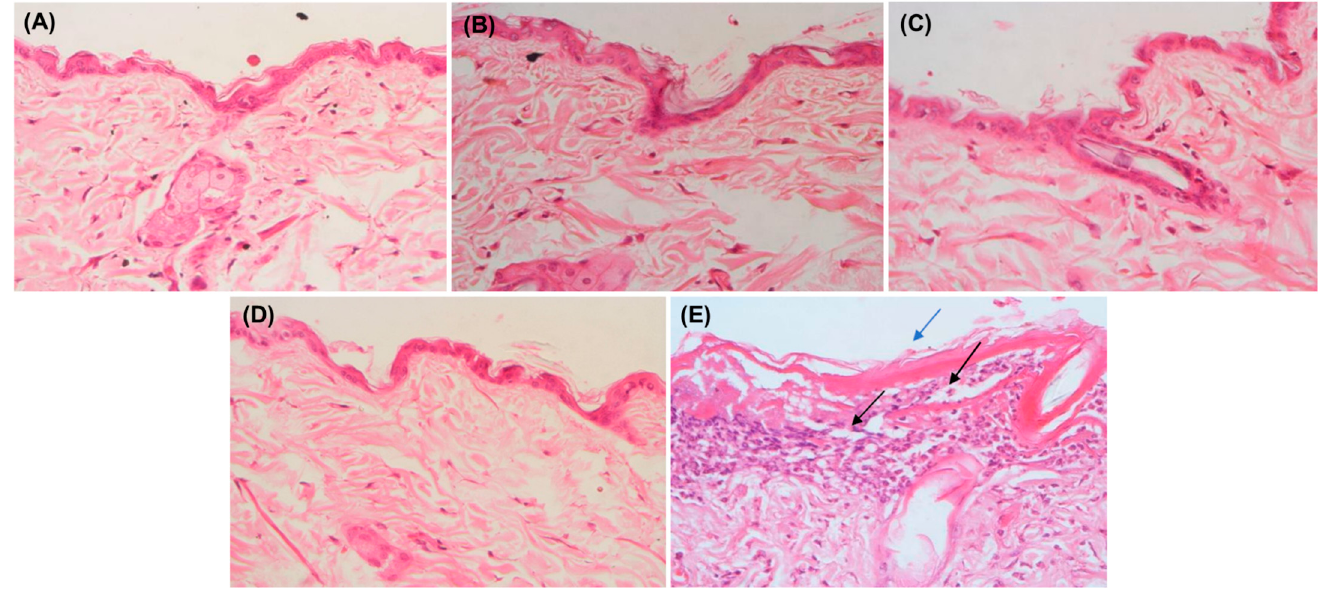
Figure 11. In vivo skin irritation study of Group I—untreated group; Group II—FDG (200 mg from 0.05% gel); Group III—CF018 emulgel (200 mg from 0.05% gel); Group IV—CF018P emulgel (200 mg from 0.05% gel); Group V—received 5% SLS gel.